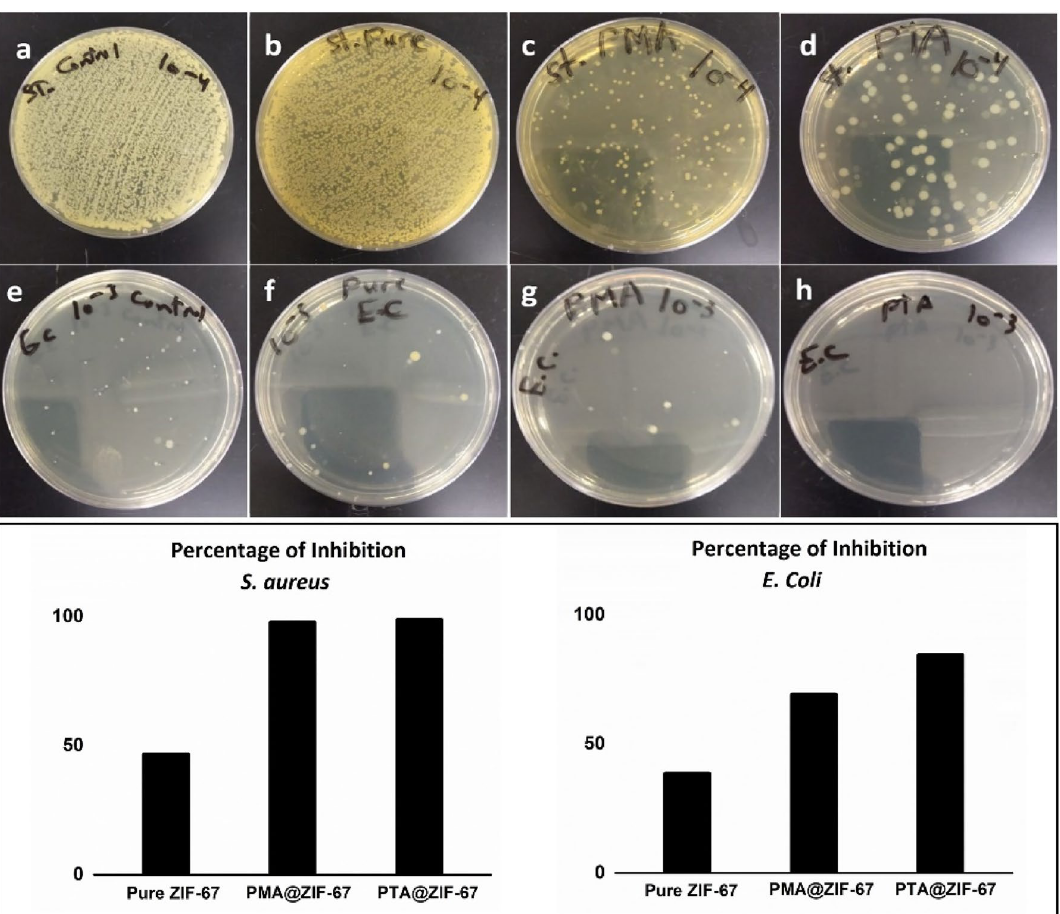
Figure 6. Gram-positive S. aurous bacterial strain against ( a ) S. aurous Control ( b ) Pure ZIF-67 MOF ( c ) PMA@ZIF-67 ( d ) PTA@ZIF-67 and Gram-negative E. Coli bacterial strain against ( e ) E. Coli Control, ( f ) Pure ZIF-67 MOF, ( g ) PMA@ZIF-67, ( h )